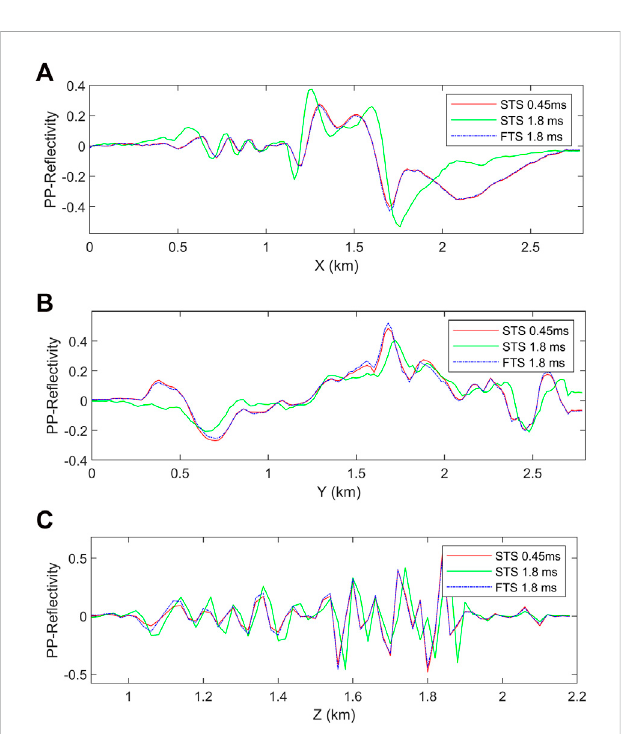
FIGURE 16 PP image pro fi les at (A) ( y , z ) = (1.6, 0.8) km, (B) ( x , z ) = (1.4, 1.8) km and (C) ( x , y ) = (2.0, 1.0) km via ERTMs using the STS and FTS methods.